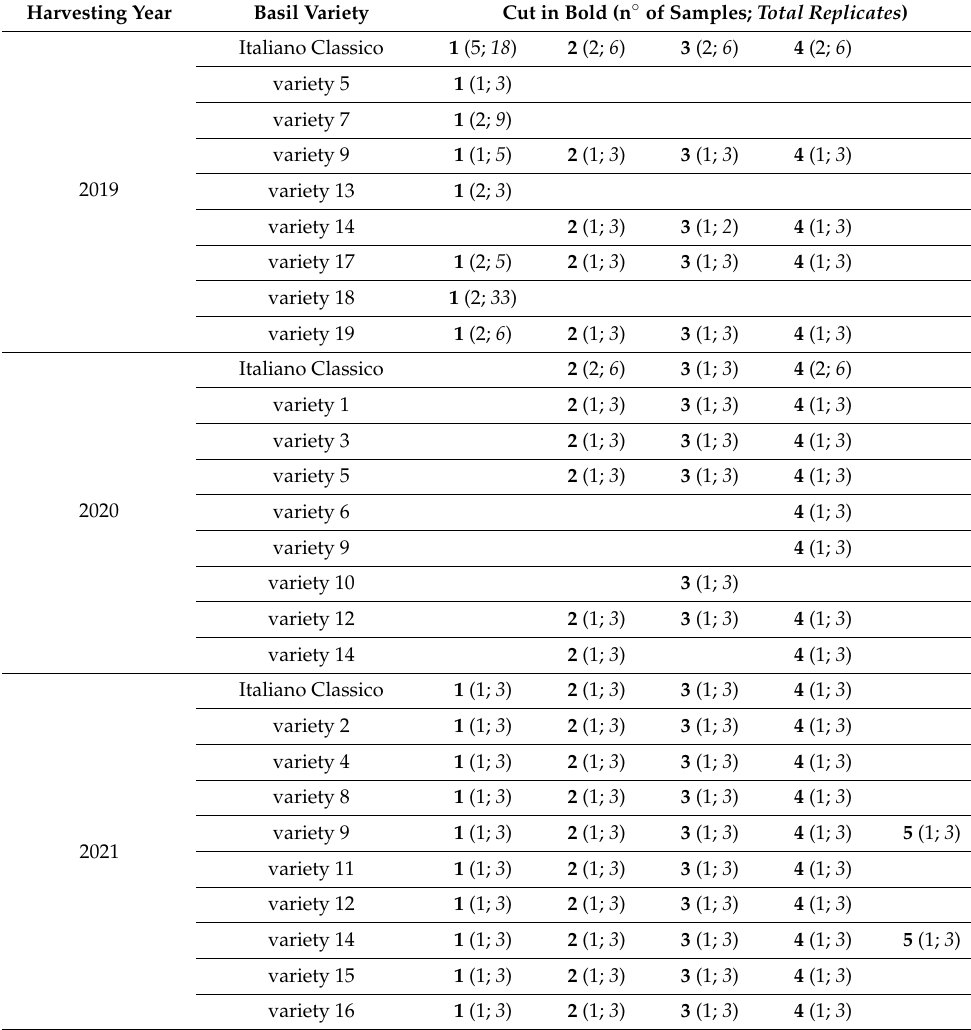
Table 1. Samples analyzed during the three years with the indication of the number of samples considered for each cut and, in italics, the number of replicates for each